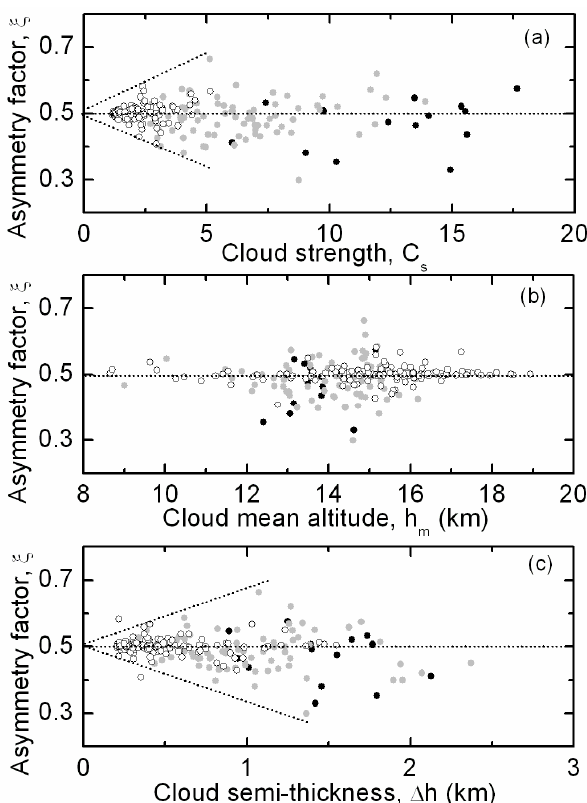
Fig. 11. Scatter plots showing the dependence of cloud asymmetry Figure 11 factor ( ξ) on cloud strength ( C s ) , cloud mean altitude ( h m ) and cloud semi-thickness ( 1h ) for tropical cirrus.